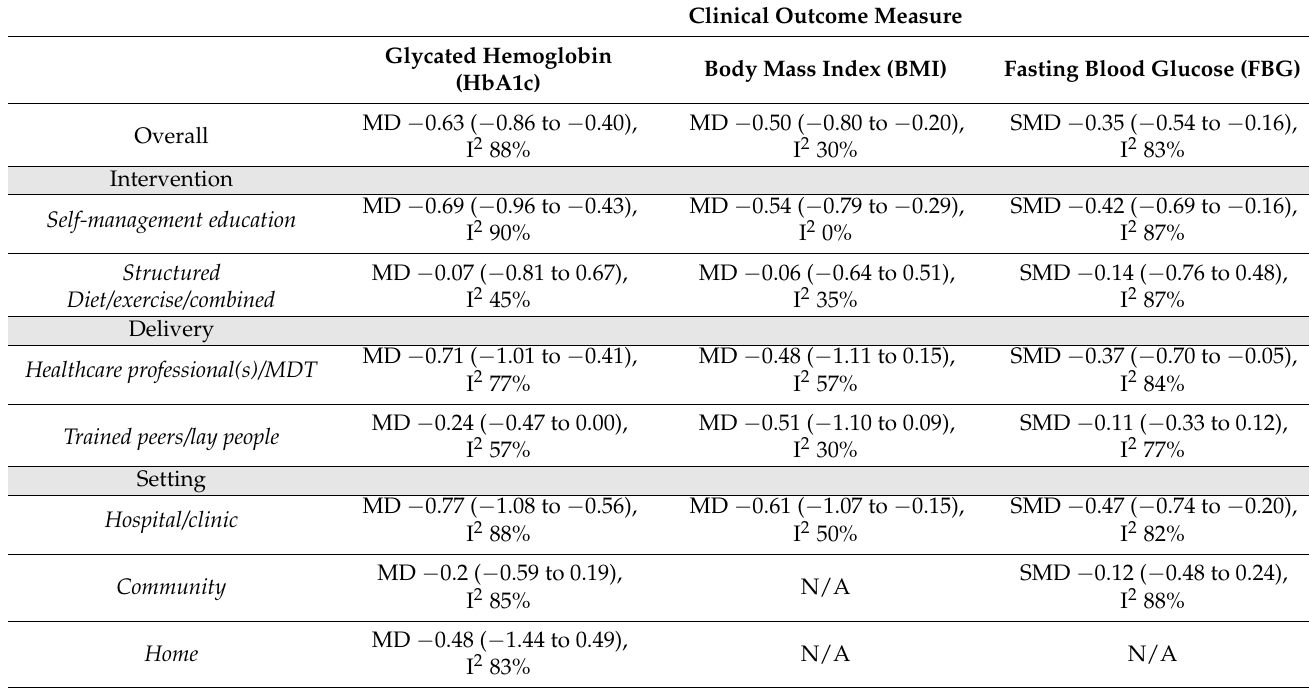
Table 2. Subgroup analysis, based on intervention type, delivery and